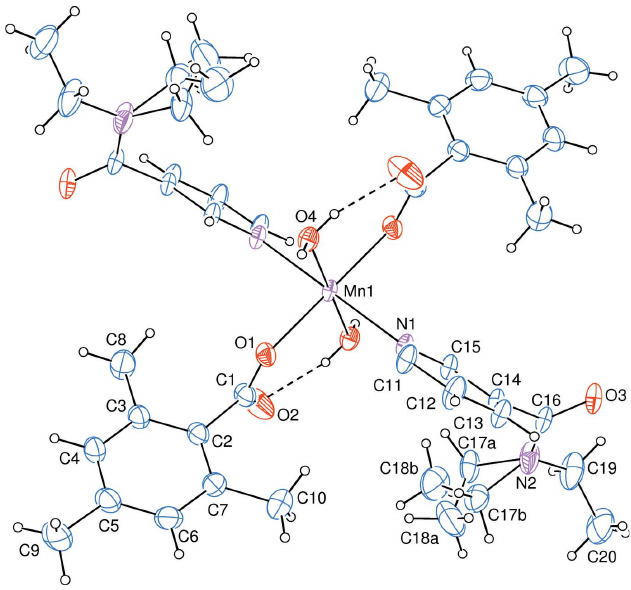
Figure 1 The molecular structure of the title complex with the atom-numbering scheme for the asymmetric unit. Unlabelled atoms are related to labelled ones by the symmetry operation ( (cid:4) x , (cid:4) y , (cid:4) z ). Displacement ellipsoids are drawn at the 50% probability level. Intramolecular O—H (cid:3)(cid:3)(cid:3) O hydrogen bonds, enclosing S (6) ring motifs, are shown as dashed